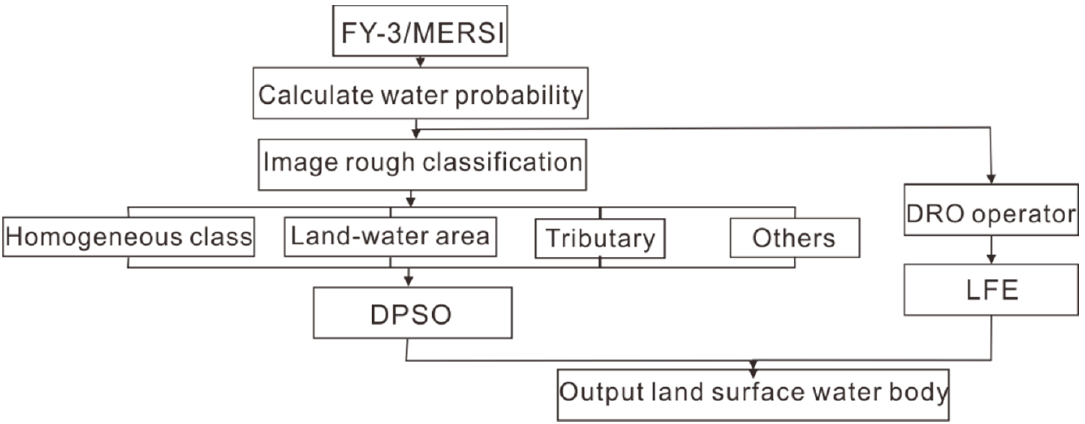
Figure 8. The flow chart of SMDPSO + linear feature enhancement (LFE).